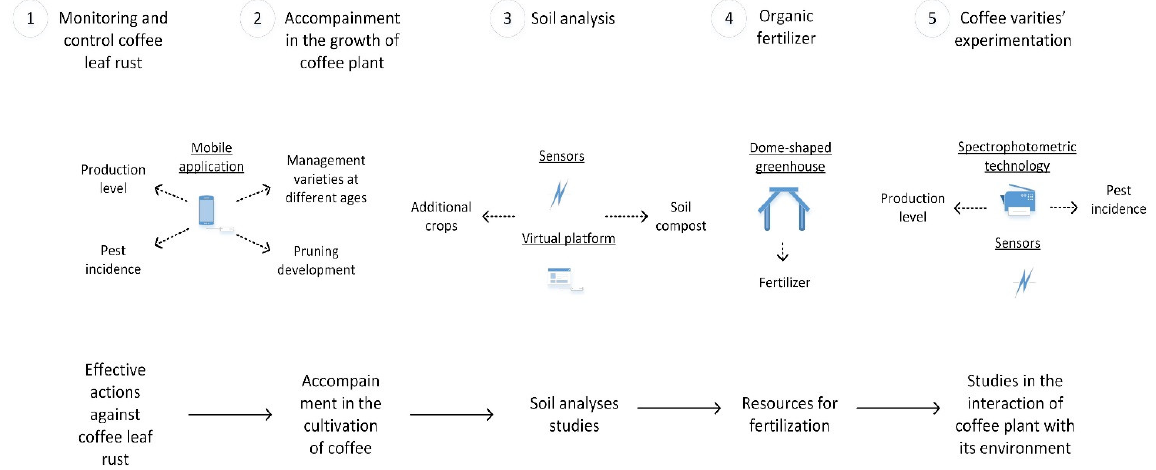
Figure 5. Technological proposal.